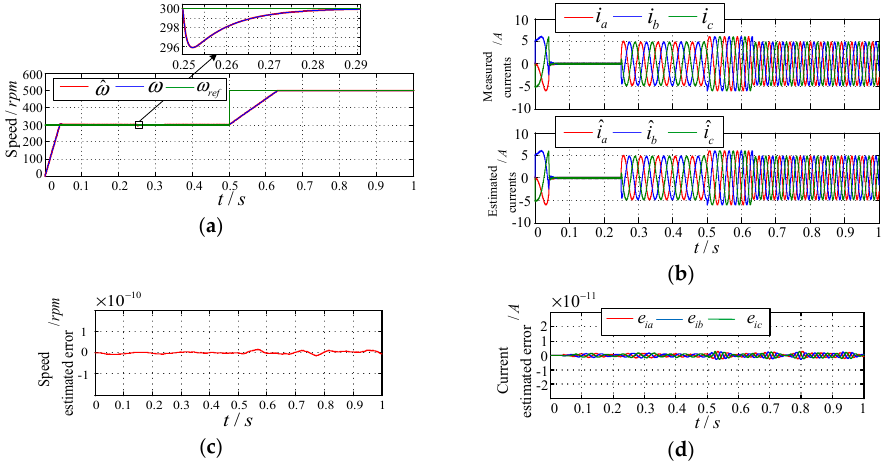
Figure 4. The simulation waveforms of PMSM drive system based on the composite sliding mode observer in the case of no sensor fault . ( a ) The given speed ω ref , the measured speed ω , and estimated speed ˆ ω ; ( b ) The measured signal i abc and estimated signal ˆ i abc of the three-phase stator current; ( c ) The estimated error of rotation speed e ω ; ( d ) The estimated error of current e i .